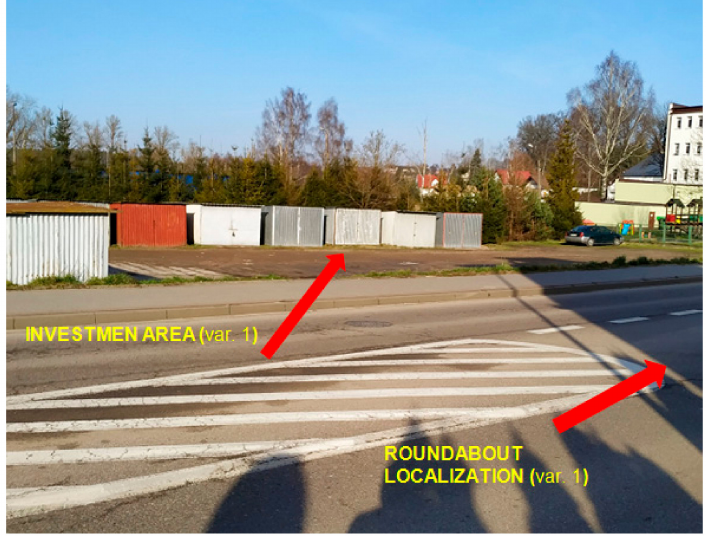
Figure 5. Location of the roundabout, land taken over for the investment in option No.